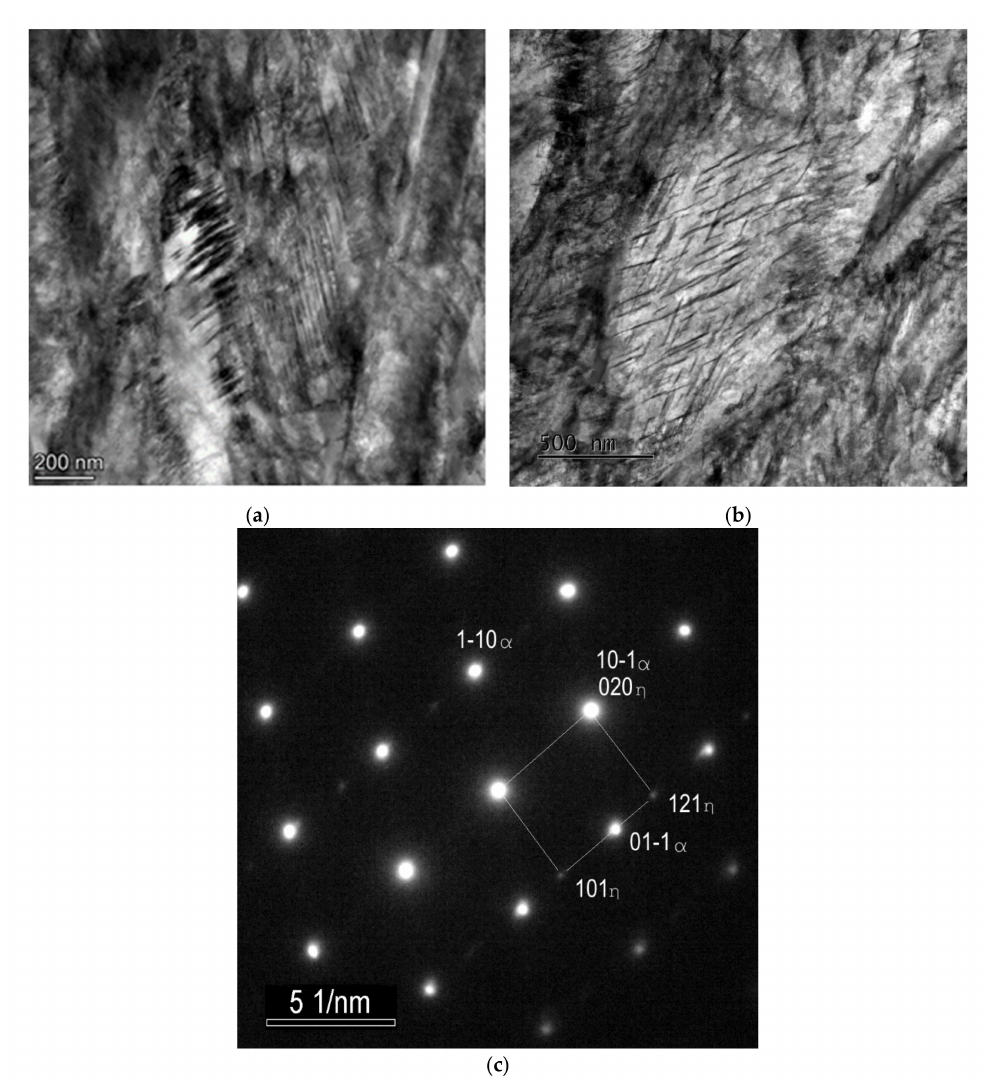
Figure 6. TEM micrographs of the sample after SAT350 processing, showing the interior of the bright island in martensite ( a ), the lath with η -Fe 2 C transition carbides ( b ), selected area electron diffraction (SAED) pattern of η -Fe 2 C carbides with zone axis [–101] ( c ). The twinned area consists of thin twins with a relatively smooth appearance, a thick- ness of several nm and a slightly thicker intertwin space (around 25 nm) with some dislocation structures. However, dislocation density does not look very high in these intertwin spaces (Figure